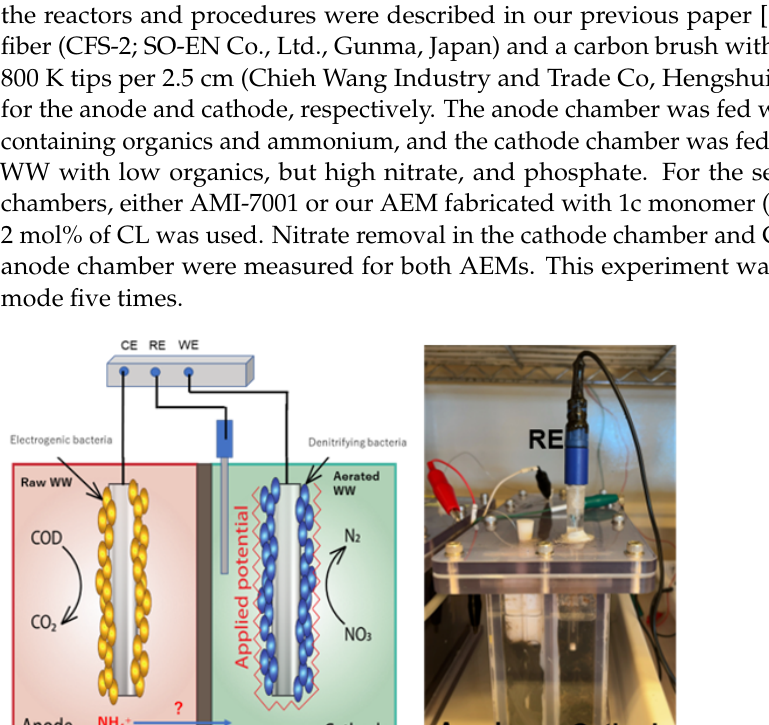
Figure 2. Schematic diagram of the electrodialysis experiment. Electrodialysis experiments using aerated swine WW were carried out using the best AEM, at 1.5 and 2 V, and with the same conditions as the phosphate buffer experiment. Initial and final phosphate and nitrate concentrations were measured and compared with the commercial AEM as a benchmark. Membrane anion selectivity was evaluated by cal- culating (as mol%) the removal of the most abundant anions (phosphate, chloride, sul- phate, and nitrate) from the aerated swine WW.